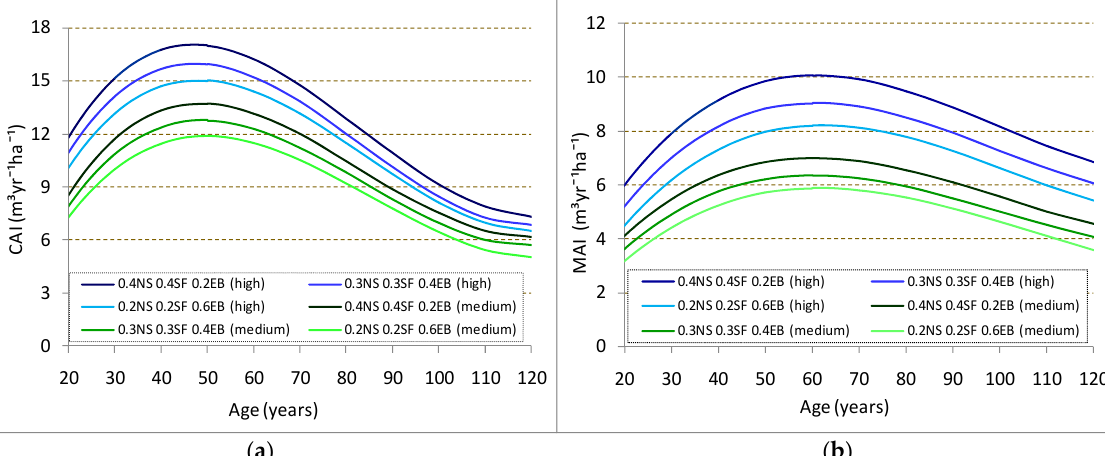
productivity sites (NS–spruce, SF–fir, EB–beech)